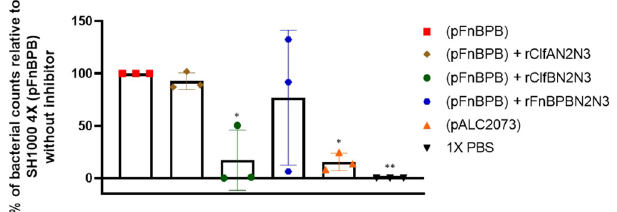
Fig. 6 Recombinant ClfB N2N3 reduces S. aureus FnBPB binding to healthy human skin corneocytes. SH1000 4X (pFnBPB) and SH1000 (pALC2073) were grown in TSB to exponential phase (OD 600 = 0.35), adjusted to an OD 600 = 1.0 and incubated with tape strips containing corneocytes previously treated with rClfAN2N3 or rClfBN2N3 or rFnBPBN2N3. Each datum point is from a different biological replicate, and the bars represent the means of three independent experiments, with error bars showing the standard deviation. A no bacteria control was used where PBS alone was incubated with the corneocytes. Tape strips were washed, and adherent bacteria were stained with crystal violet. The number of bacterial cells adhering to ten corneocytes was counted and the percentage of adherence is shown in comparison with the total adherence of SH1000 4X (pFnBPB) to corneocytes that were not pretreated with recombinant protein. Statistical analysis was performed using a one-way ANOVA with a Dunnett´s multiple comparison test to compare variances between S. aureus SH1000 4X (pFnBPB) adhering to corneocytes without recombinant protein to the S. aureus SH1000 4X (pALC2073) adhering to corneocytes without recombinant protein, SH1000 4X (pFnBPB) adhering to corneocytes with recombinant protein, and the no bacteria control.* P = 0.0160 (SH1000 4X (pFnBPB) vs SH1000 4X (pALC2073) and P = 0.0178 (SH1000 4X (pFnBPB) vs SH1000 4X (pFnBPB) + rClfBN2N3), P = 0.0051 (SH1000 4X (pFnBPB) vs 1X